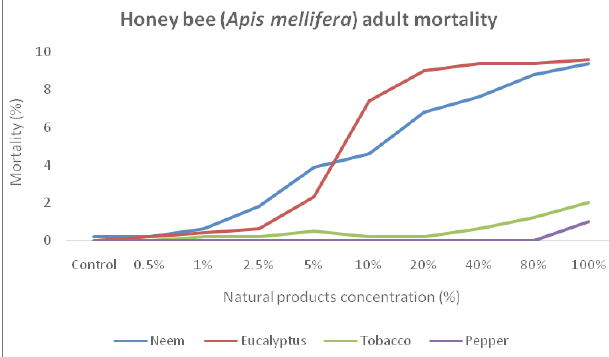
Fig 2. Adult honey beemortality for the different natural products atvarious concentrations (%).